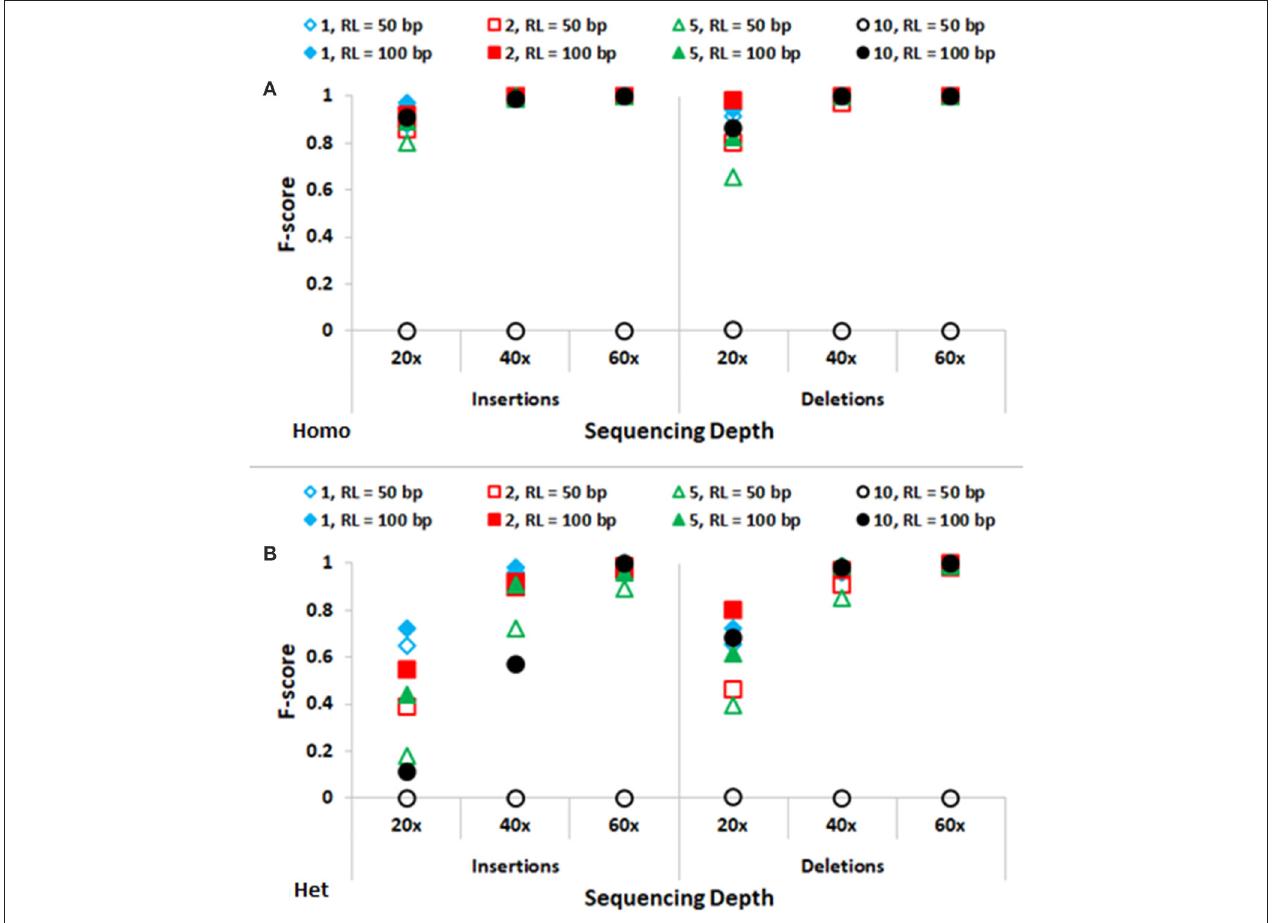
FIGURE 3 | Performance of SeqVItA in detecting INDELs in simulated data shown. F-score values for predicting (A) homozygous (Homo) and (B) heterozygous (Het) INDELs of various sizes: 1 bp (“diamond”), 2 bp (“square”), 5 bp (“triangle”) and 10 bp (“circle”) for two read lengths 50 bp (empty symbols) and 100 bp (filled symbols). Minimum coverage threshold = 10 and Base quality ≥